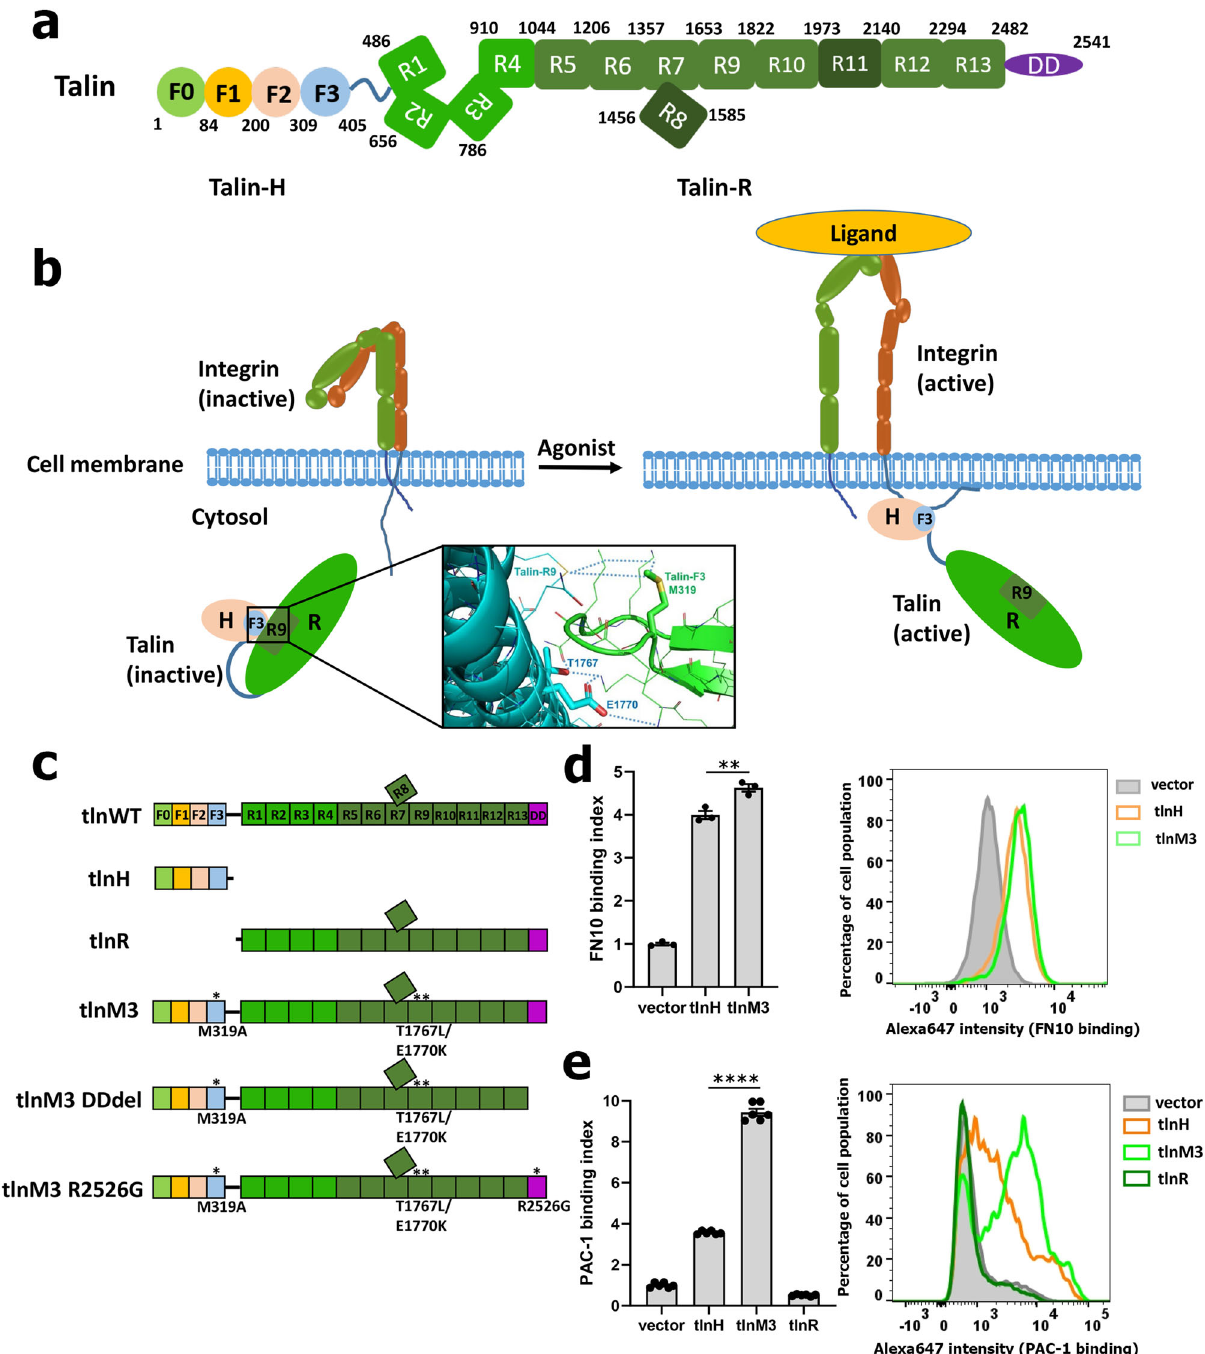
Fig. 1 Talin is an intracellular activator of integrin. a Domain organization of talin. N-terminal head domain (talin-H) is composed of four subdomains and C-terminal rod domain (talin-R) contains 13 subdomains followed by dimerization domain (DD). Talin-H and talin-R are connected by a fl exible linker. b A scheme of talin activation and talin-mediated integrin activation. Upon stimulation, inactive talin is released from an autoinhibited state to expose talin-H to bind integrin cytoplasmic tail and trigger conformational change of integrin to bind ligand. The autoinhibitory interface between talin F3 and talin R9 is displayed in the box showing how M319, T1767, and E1770 are involved in the interface and mutated to release the autoinhibiton. c Diagram of the various talin variants, including mutation sites to activate talin or disrupt talin dimerization. d Left panel: Integrin-activation level re fl ected by monomeric FN10 binding is not elevated much by constitutively activated full-length talin mutant, (tlnM3) compared with talin-H (tlnH). ** p = 0.0081 with 95% con fi dence interval 0.2727 – 0.9914 ( t- test), N = 3 biologically independent samples. All values are given as mean ± S.E.M. Right panel: FN10 staining was similar between tlnH (orange) and tlnM3 (light green). e Left panel: Integrin-activation level re fl ected by PAC-1 binding is substantially elevated by tlnM3 compared with tlnH. Talin rod (tlnR) alone has no effect on integrin activation. **** p < 0.0001 with 95% con fi dence interval 5.478 – 6.260 ( t- test), N = 6 biologically independent samples. All values are given as mean ± S.E.M. Right panel: Signi fi cantly more PAC-1 staining was induced by intact active talin (tlnM3, light green) in comparison with talin head (tlnH, orange) without normalization. d , e Raw data are provided in Source Data fi le.